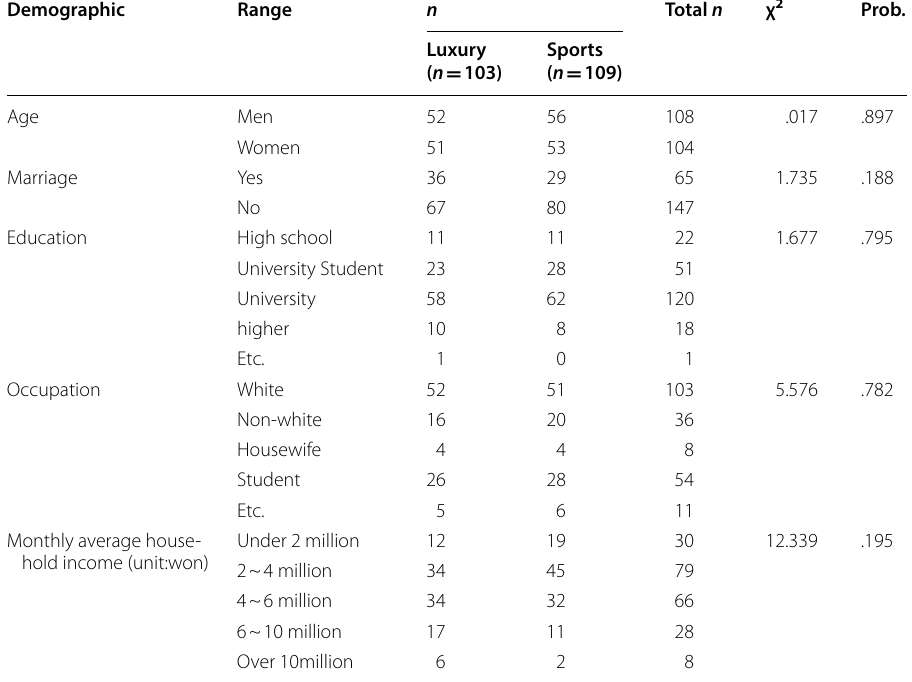
Table 1 Demographic characteristics of the respondents